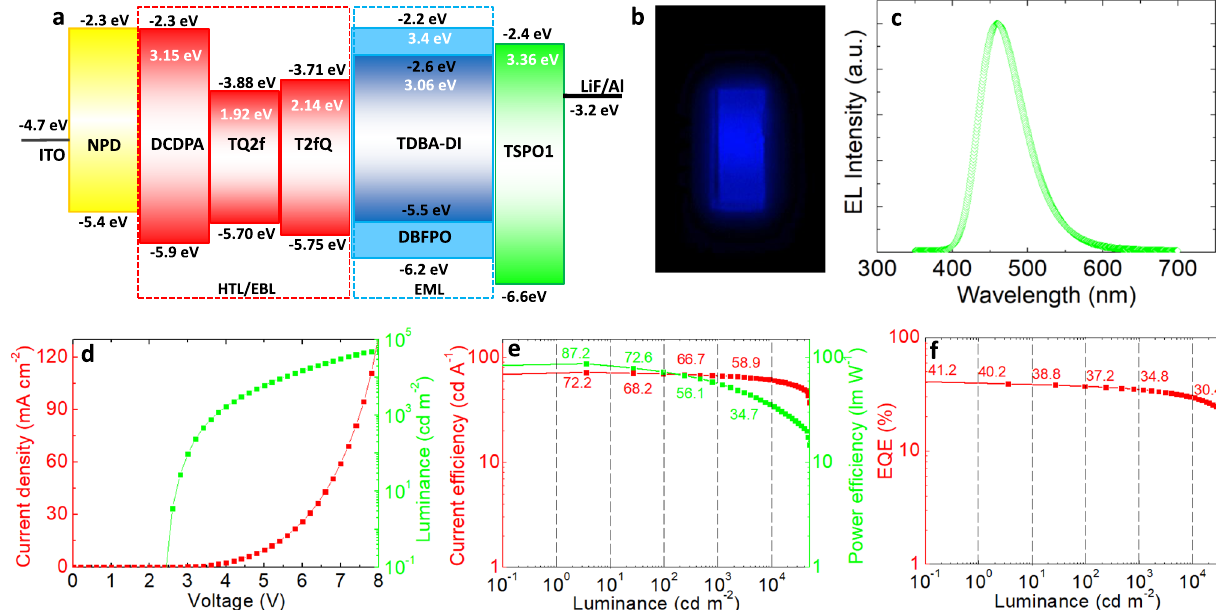
Fig. 3 Performance of optimized blue TADF OLEDs and ef fi ciency roll-off. a The energy-level diagram of the layers sequence in the blue TADF OLED device architecture considering vacuum level alignment before contact. Besides HOMO and LUMO energies of organic layers, the triplet energy of the emitter, host, and interlayer materials are also presented. b Photograph of a working OLED pixel with an active area of 25 mm 2 and c electroluminescence spectrum of the same device. d Current density – luminance – voltage characteristics, e current and power ef fi ciency vs. luminance, and f EQE vs. luminance characteristics for the OLED.